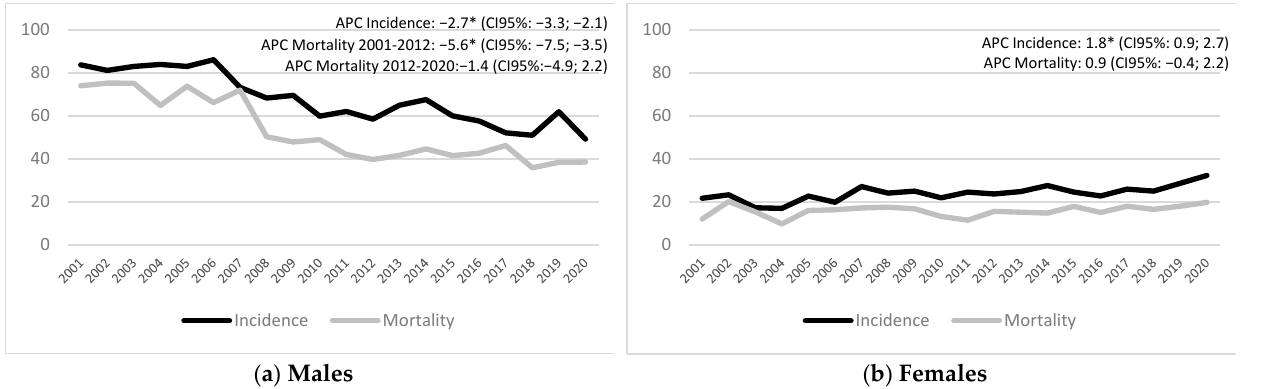
Figure 1. Incidence and mortality trend of lung cancer in males ( a ) and females ( b ). Years: 2001–2020. * APC is significantly different from zero at the α = 0.05 level.